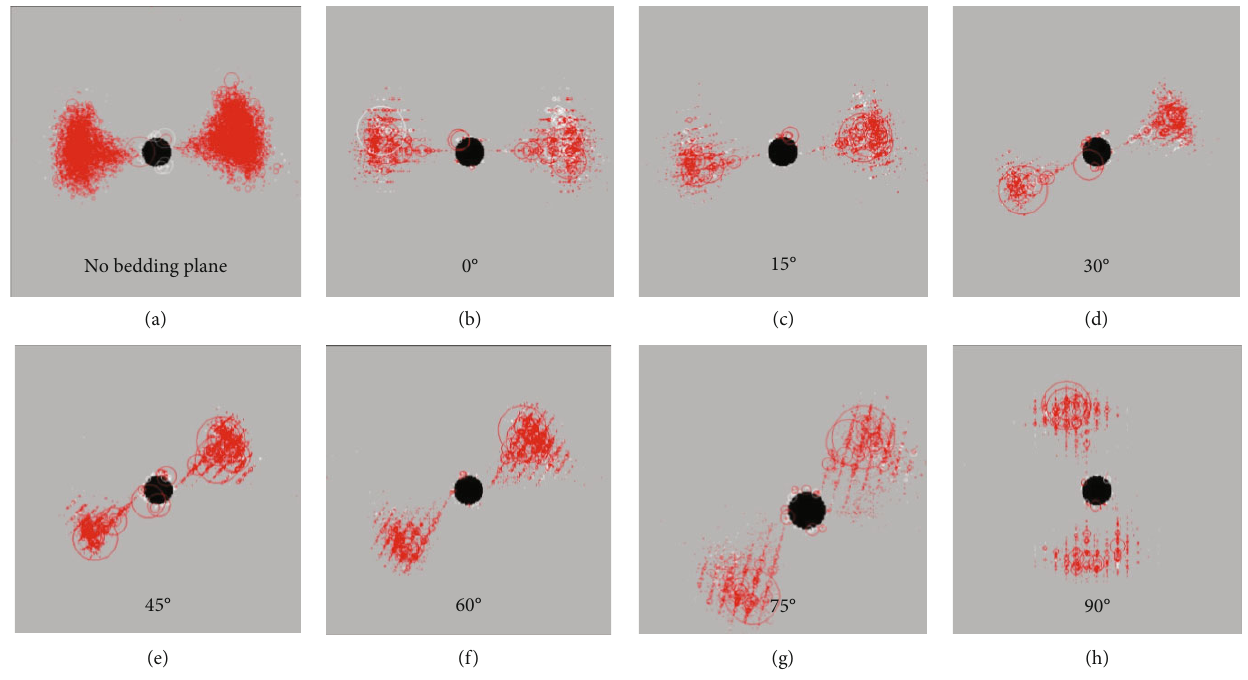
Figure 12: Acoustic emission under di ff erent BP